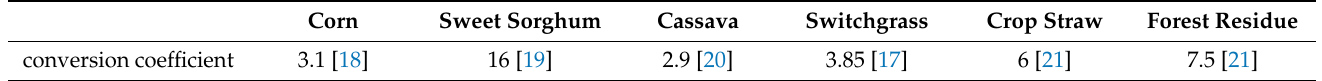
Table 2. Bioethanol conversion